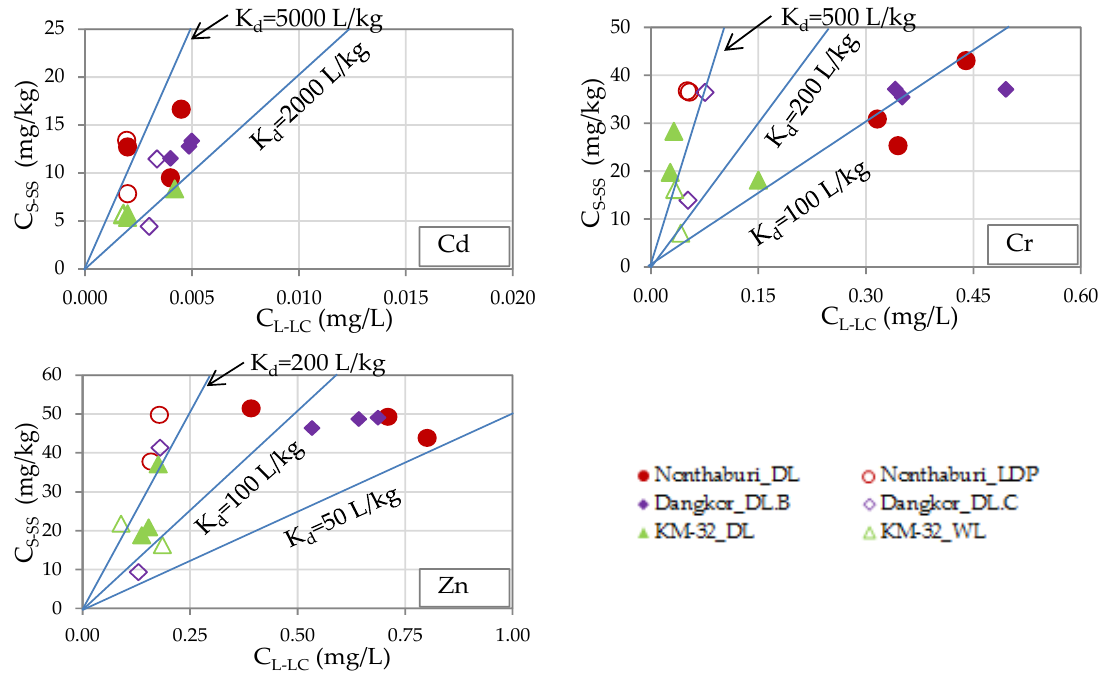
Figure 12. Relationship of the heavy metal content of suspended solids (C S-SS ) and the liquid part of the leachate (C L-LC